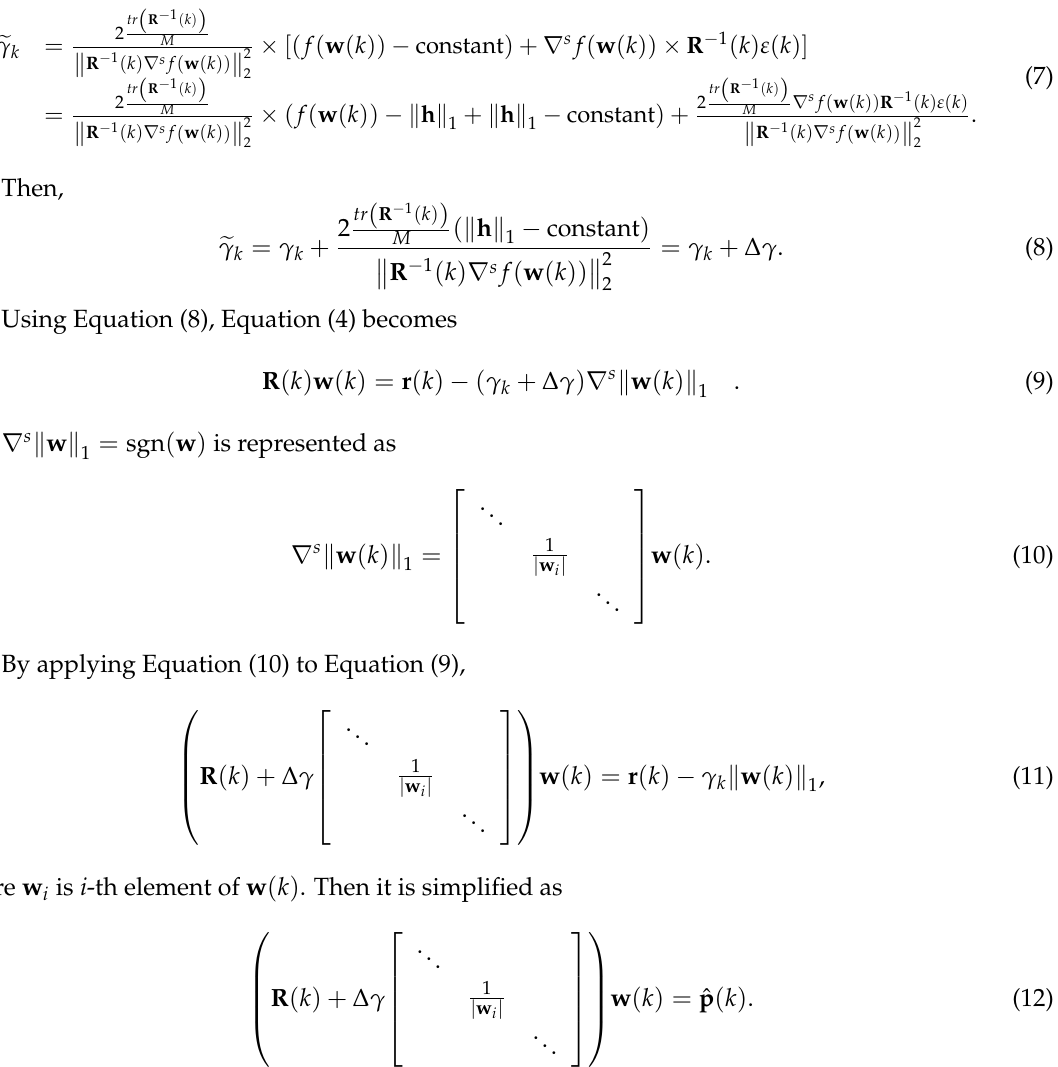
(cid:18) (cid:19) (cid:107) ˆ w (cid:107) −√ 1 − [20] 1 √ L L L (cid:107) ˆ w (cid:107) 2